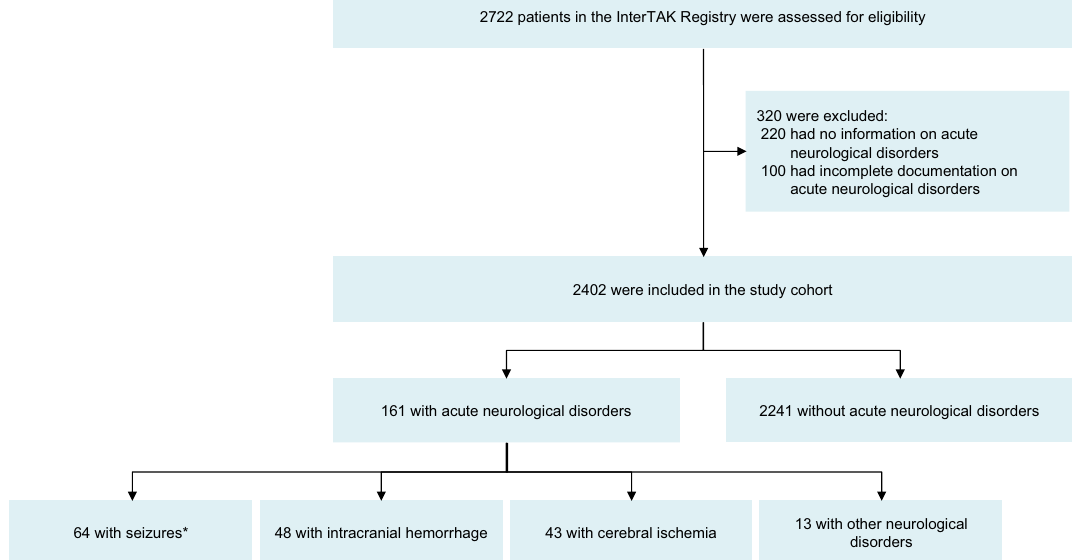
Figure 1. Study population. *7 patients had overlap of 2 acute neurological conditions and were classified twice: 2 with focal onset seizure and ischemic stroke, 2 with generalized onset seizure and PRES, 1 with status epilepticus and PRES, 1 with status epilepticus and SAH, and 1 with generalized onset seizure and SAH. InterTAK Registry International Takotsubo Registry, PRES Posterior reversible encephalopathy syndrome, SAH Subarachnoid